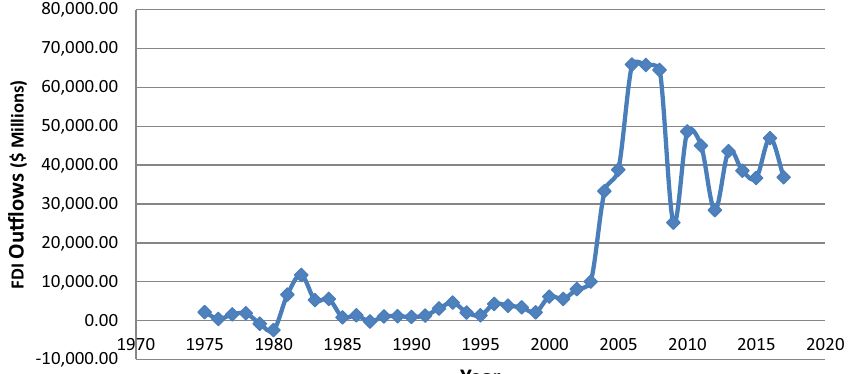
Figure 2. Foreign direct investment outflows in the MENA